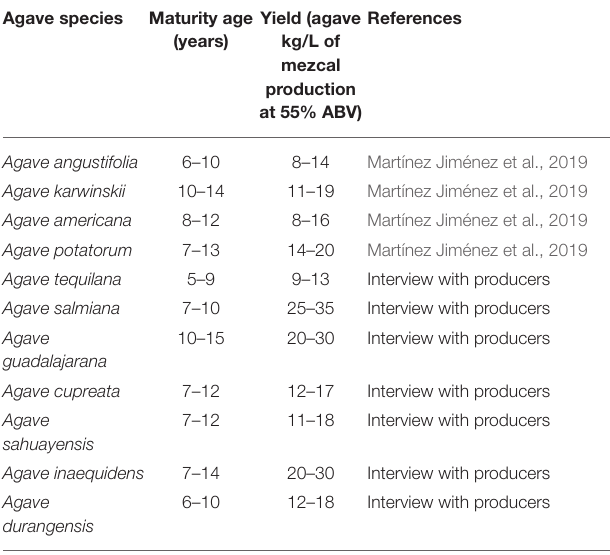
TABLE 5 | Comparison of maturity age, production yields of different Agave species in different production